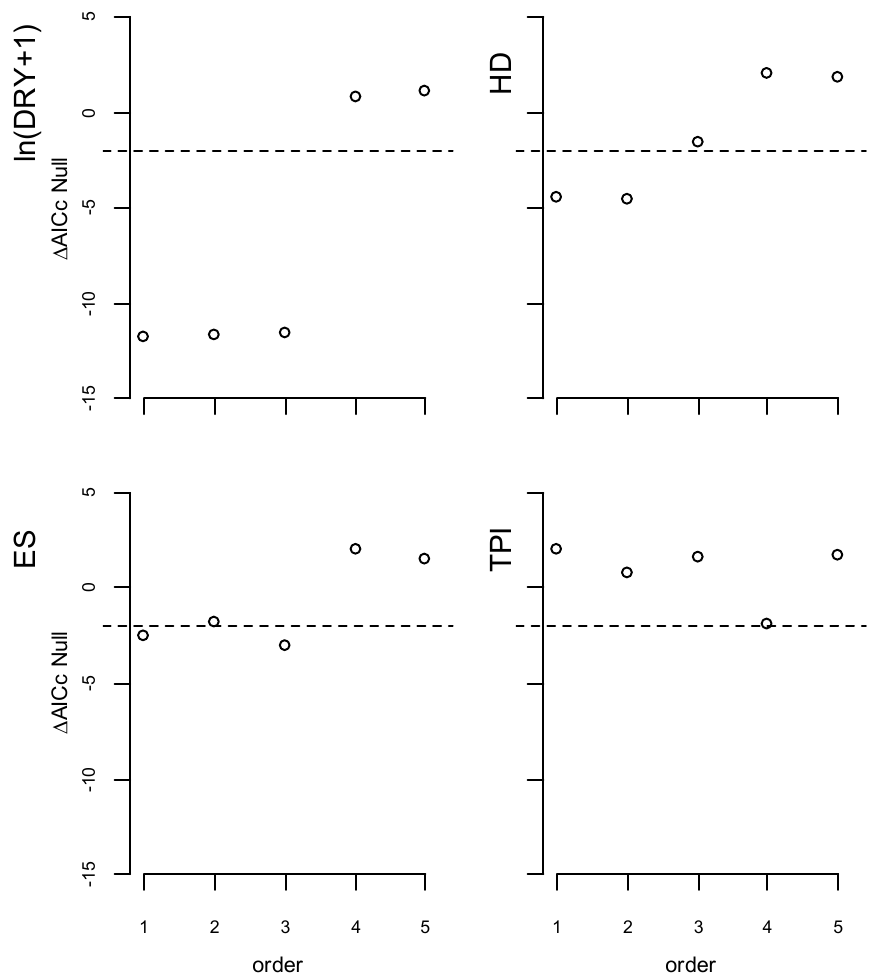
Figure 5. AICc difference with the null model ( ∆ AICcNull) for the Cox univariate models with four variables (ln(DRY + 1), HD, ES, TPI) (see Table 1) and scale Orders 1–5 (see Figure 2). The dotted lines indicate ∆ AICc = − 2. Dots under the line are better than the null model [67,69], and full dots indicate variables qualified for model selection (Table 3).